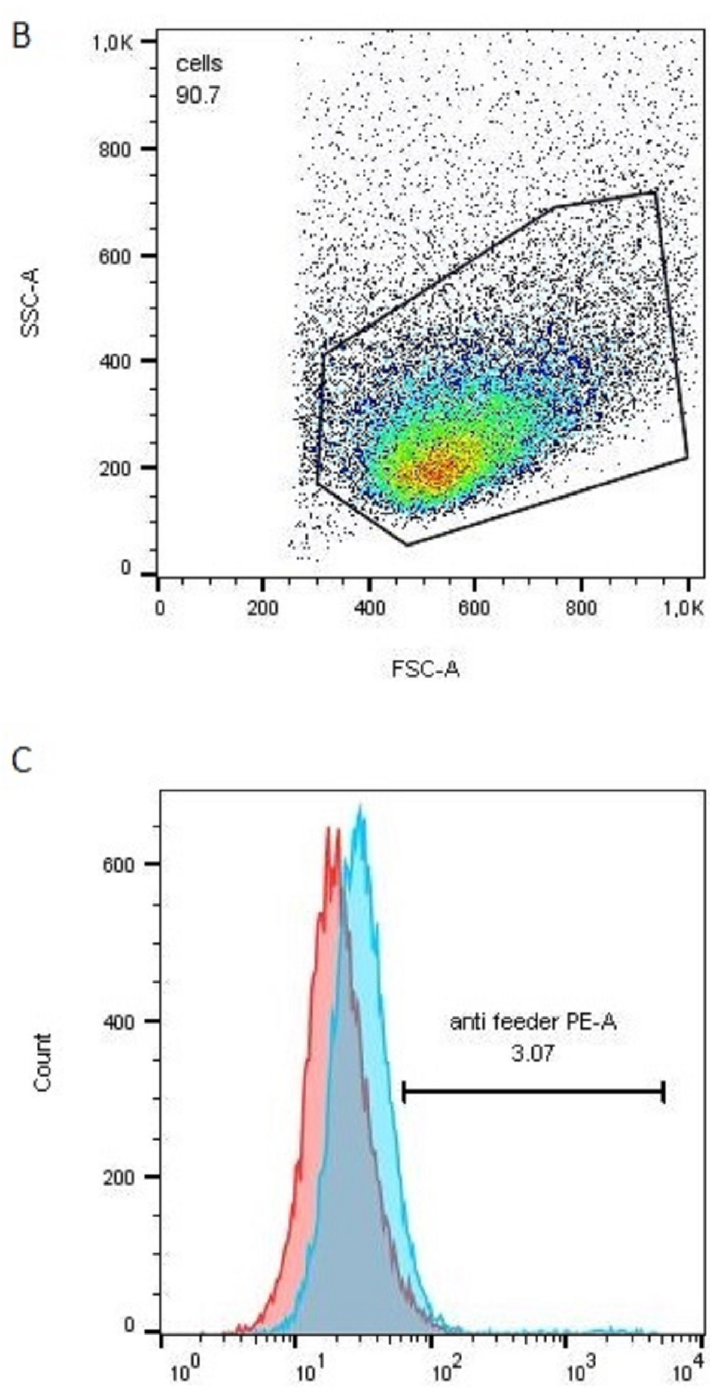
Figure 11. Flow cytometric representative analysis of the proportion of 3T3 feeder cells after removal from the unmodified PLA scaffold (sample 1); ( A ) 79.9% of acquired events in the gate 1 are singlets based on (forward light scatter-area vs. forward light scatter-height) FSC-A vs. FSC-H signal distribution; ( B ) singlets from the gate 1 were analyzed using FSC-A and (sideward light scatter-area) SSC-A signals and individual cells are gated as gate 2 (90.9% of events in gate 1); ( C ) histogram of cells from the gate 2 was analyzed for PE fluorescence for isotype PE-conjugated antibody (red line) or specific anti-feeder cells PE-conjugated antibody (blue line). The limit of the negative/positive signals for feeder cells was set at 1% on a sample labeled with an isotype